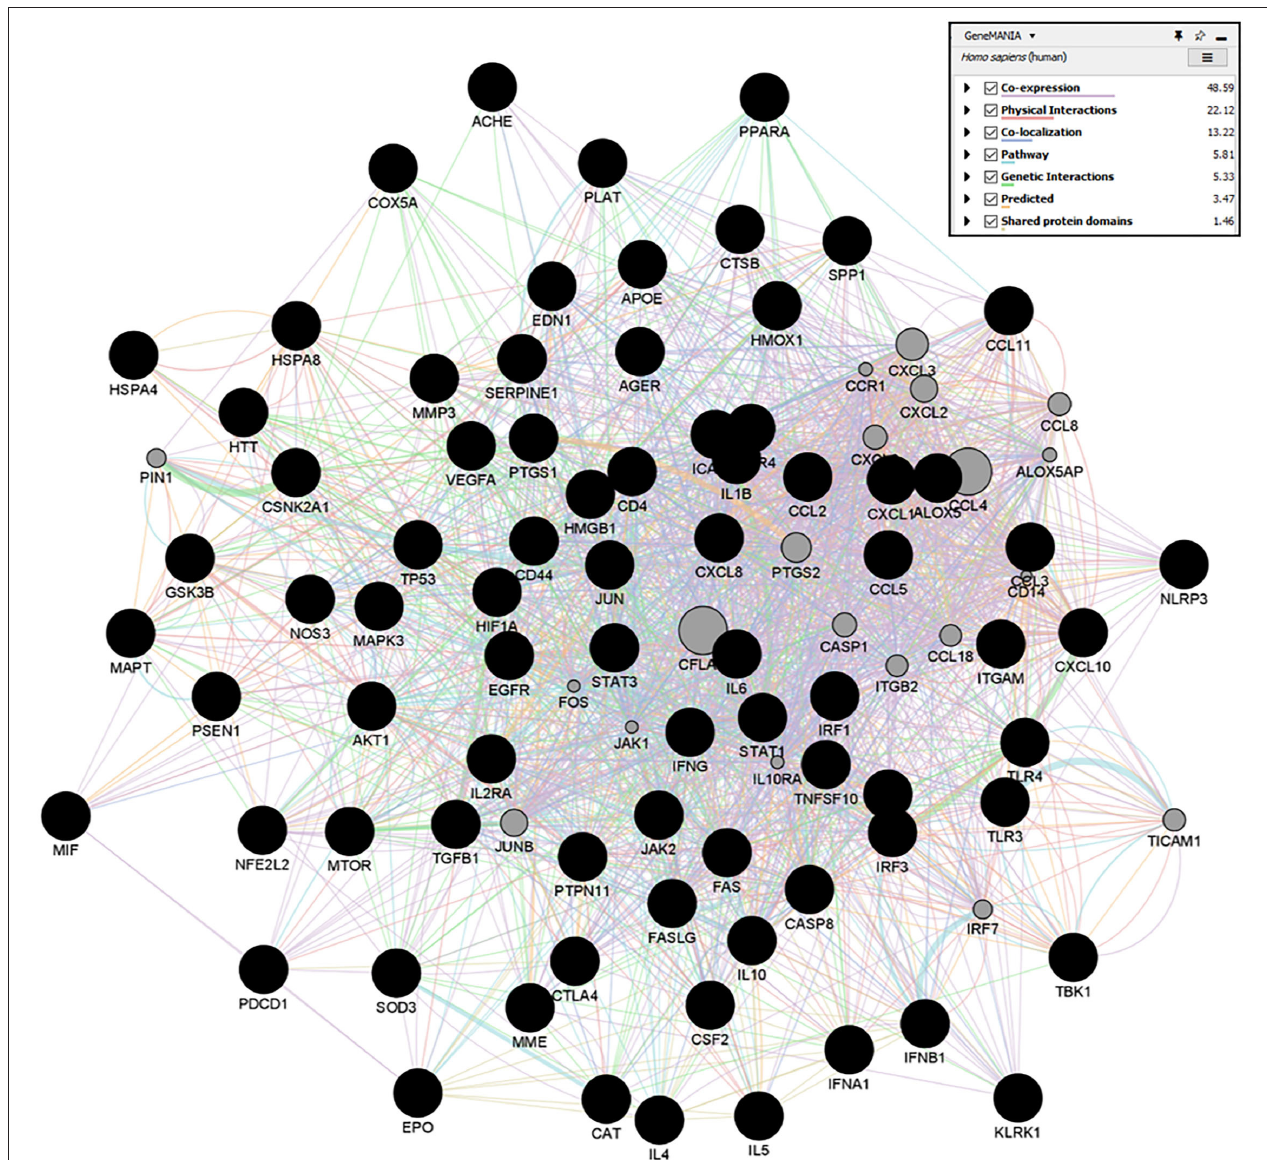
FIGURE 13 | GeneMANIA networks showing the gene-gene interaction results of Quercetin targets. Network displays the strength of interaction (edge thickness), type of interaction (colors), many edges in between nodes, and the score (size of